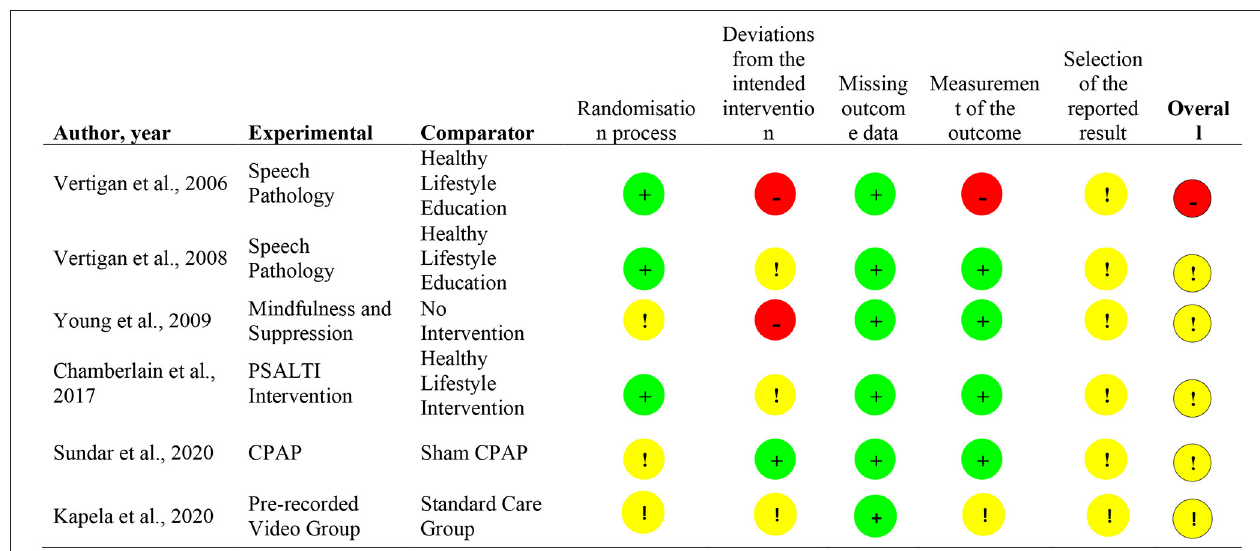
FIGURE 4 | Risk of Bias Summary